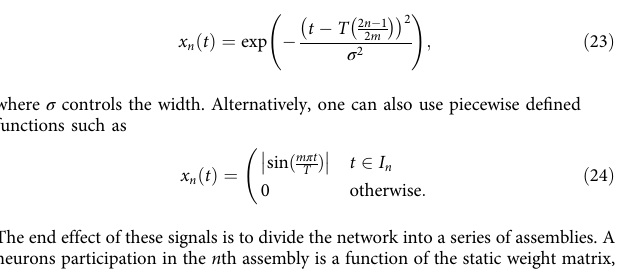
Figure 4 methods . The teaching signal consisted of the spectrogram for a 5s long recording of the singing behavior of a male zebra fi nch that was generated with a 22.7 ms window. This data were obtained from the CRCNS data repository 75 . The RA network consisted of 1000 neurons that was FORCE trained for 50 s with G = 1.3 ×10 4 , Q = 1× 10 3 , λ − 1 = 2ms, Δ t = 4ms and an integration time step of 0.04 ms. The average fi ring rate for the network was 52.93 Hz. The HVC input was modeled as a sequence of 500 pulses that were constructed from the positive component of a sinusoidal oscillation with a period of 20 ms. The pulses fi red in a chain starting with the fi rst component. This chain was multiplied by a static, N × 500 feedforward weight matrix, W in where each weight was drawn uniformly from the [ − 8× 10 3 , 8× 10 3 ]. The network was tested for another 50 s after RLS was turned off to test if learning was successful. We note that for this songbird example, the network could also learn the output with only the static, chaos inducing weight matrix and the feedforward HVC inputs ( Q = 0). However when Q = 0, the net- work behavior is similar to the more classic liquid state regime. To manipulate the weight matrix post training, we introduced a parameter α that allowed us to control the balance between excitation and inhibition: